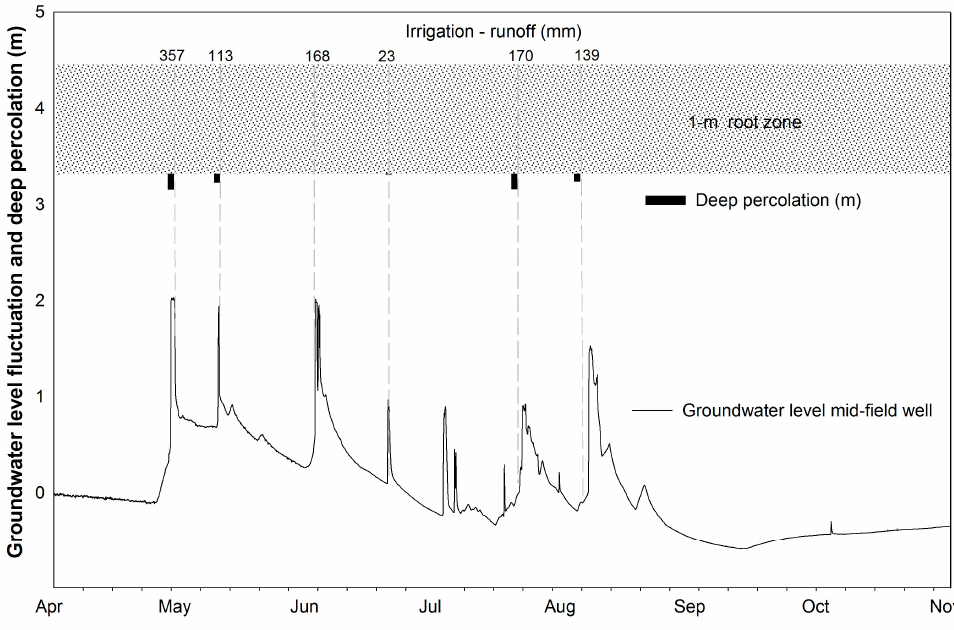
Figure 4. Irrigation water application, deep percolation, and shallow groundwater level fluctuations observed at the El Rito study site.